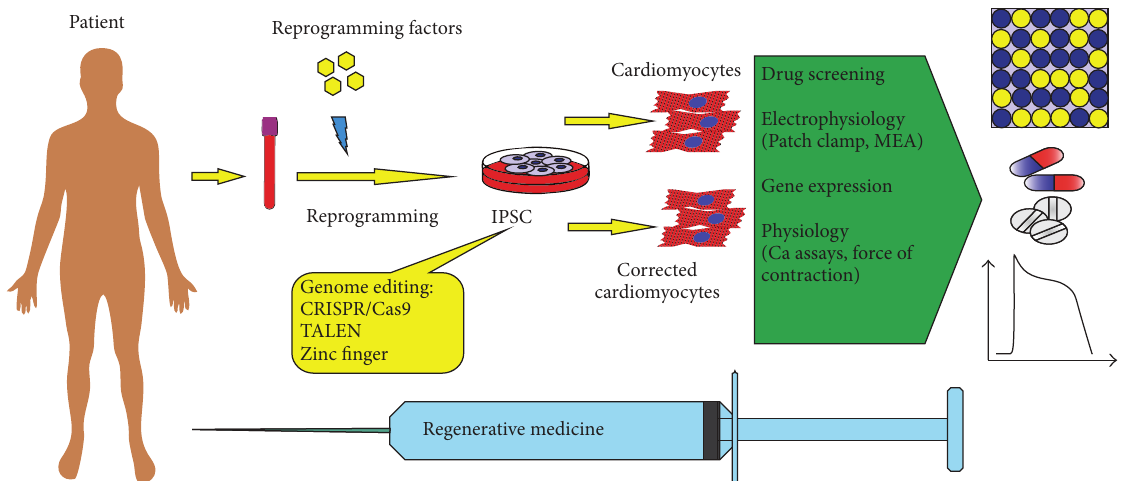
Figure 2: Genome editing in cardiovascular disease modeling with induced pluripotent stem cells. Patient-specific induced pluripotent stem cells are corrected using genome editing tools to create a panel of isogenic iPSC lines that are differentiated into cardiomyocytes for disease modeling, drug discovery and screening, and cell